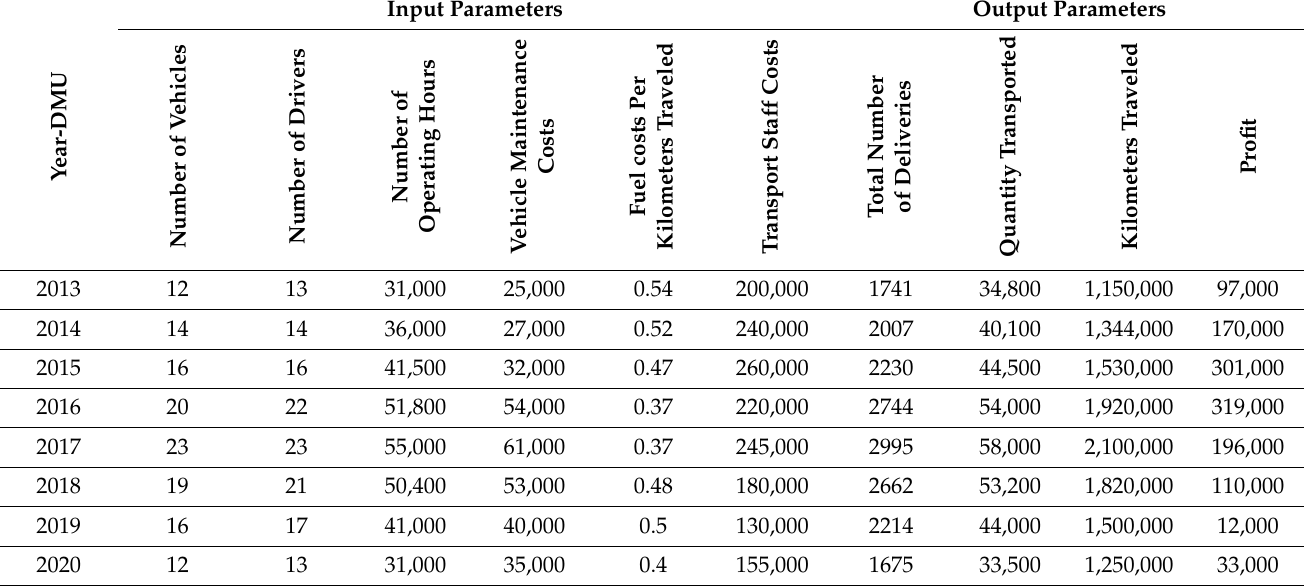
Table 3. Input and output parameters of company